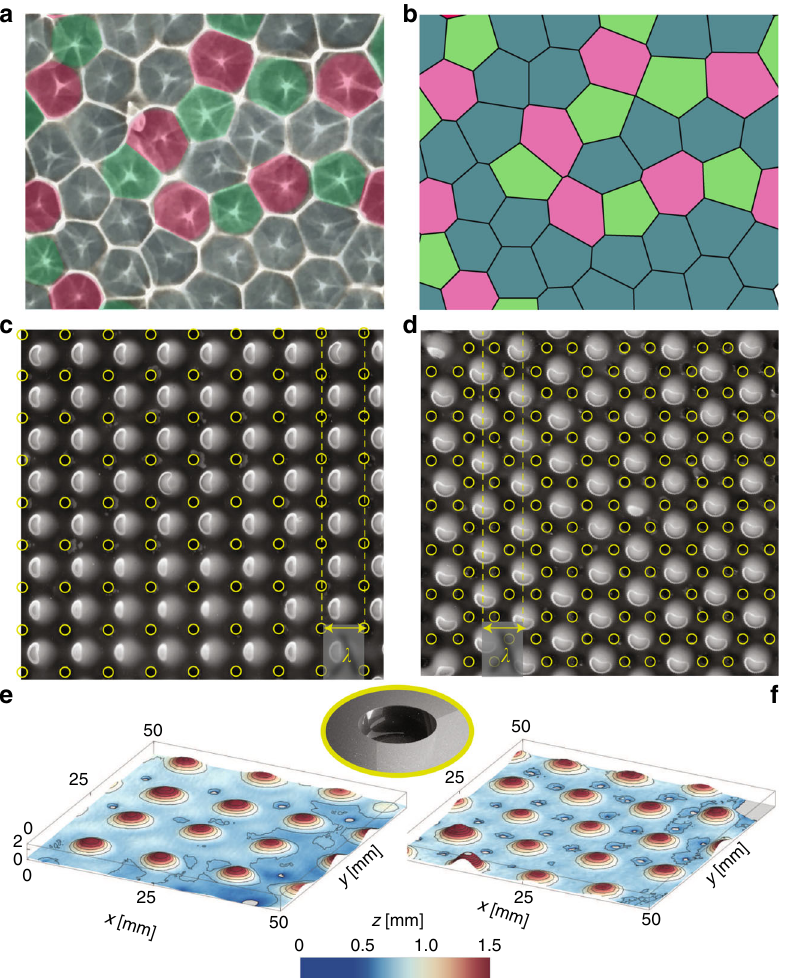
Fig. 2 Control of the drop lattice. a Optical projection of the PDMS drop lattice on a fl at surface. Areas are color-coded according to the type of polygon encountered. b Voronoi mesh of the drop lattice in a . Hexagons appear in blue, pentagons in green, and heptagons in pink. c , d Experimental pictures of square and hexagonal patterns forced using seeds (shown in yellow and in inset) with wavelength λ . e , f 3D scans of the same droplets, showing